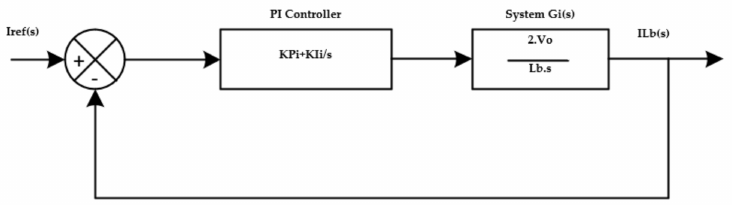
Figure 12. Block diagram of the inner current control system with PI controller. The TF of the closed loop current-control loop can be expressed